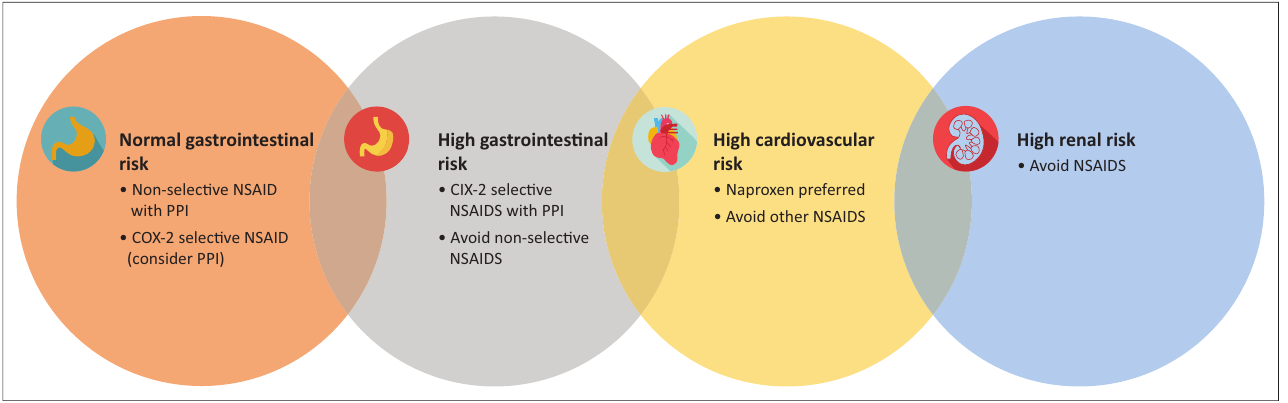
FIGURE 2: Osteoarthritis pathological findings. 14 (a) A joint with mild Osteoarthritis and (b) a joint that has been deformed by severe Osteoarthritis.